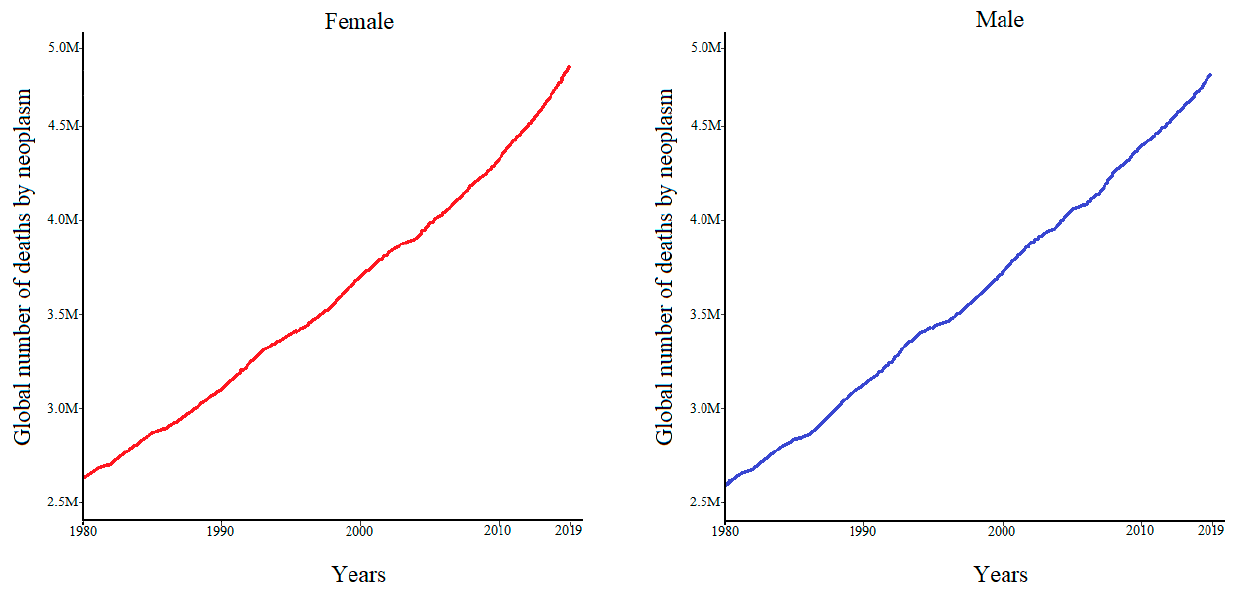
Figure 1. Global numbers of deaths by cancer over the years, according to the Institute for Health Metrics and Evaluation.